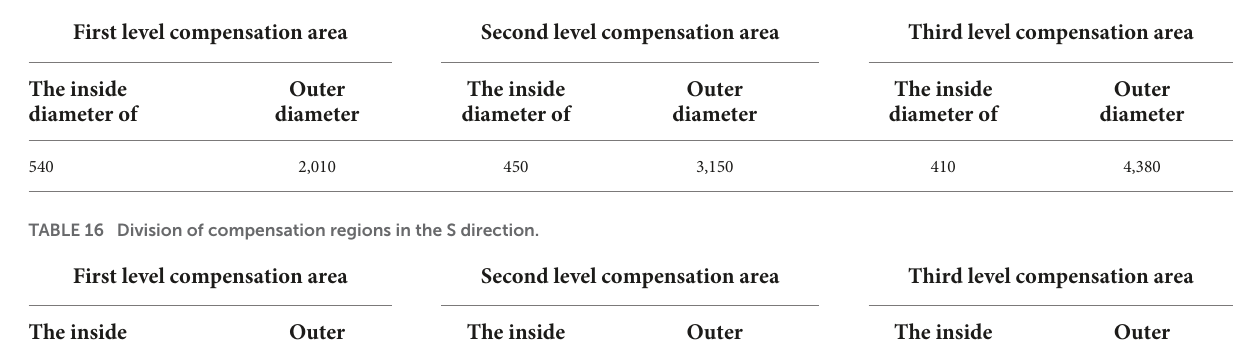
TABLE 15 Compensation area division in the SE direction.